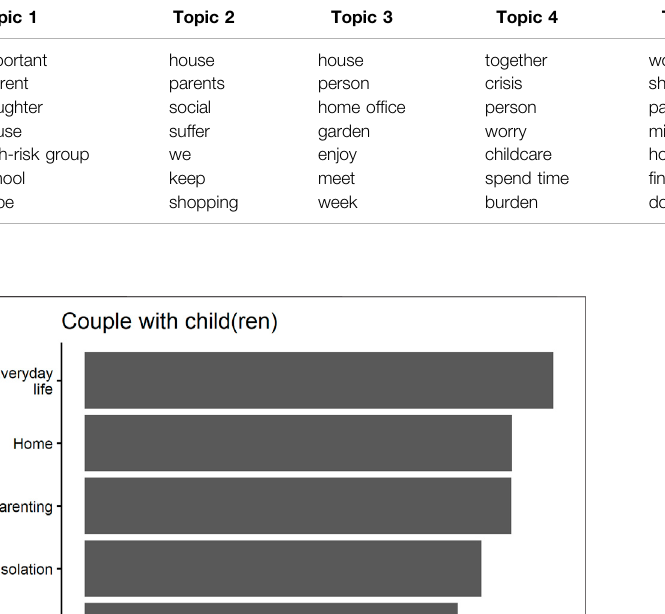
TABLE 4 | Topics of couples with child(ren) (n (cid:1) 328). Topic 1